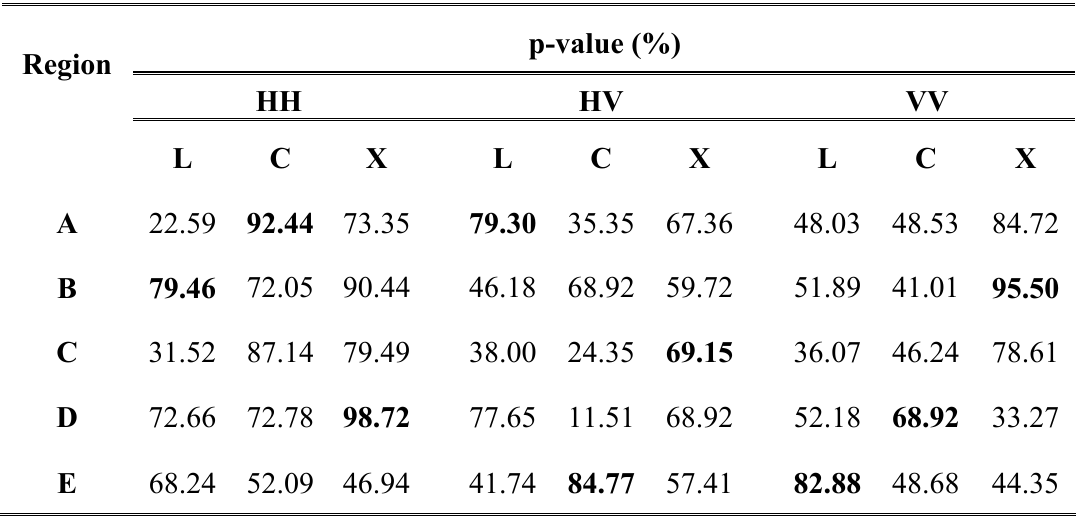
Table 2 . P-values for the χ 2 goodness-of-fit.